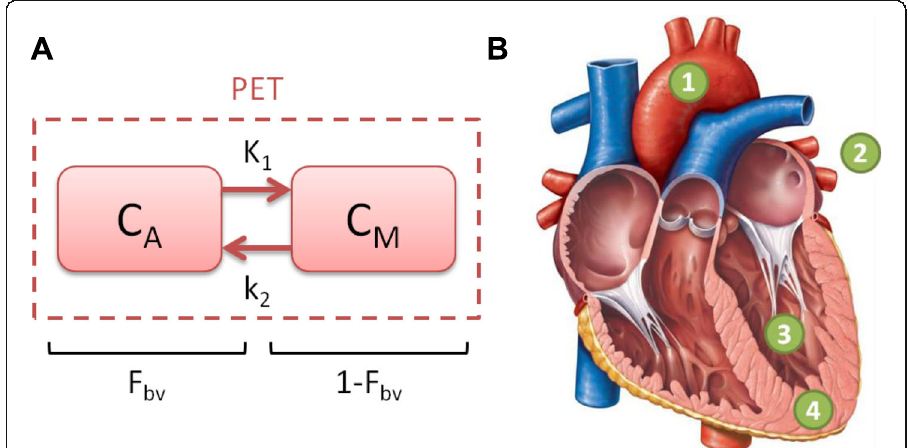
Fig. 2 a Schematic diagram of the 1 compartment 3 parameter tracer kinetic model. b Heart diagram indicating the points of reference as described in Eqns. 1 – 6 (reproduced with permission from Pearson Education